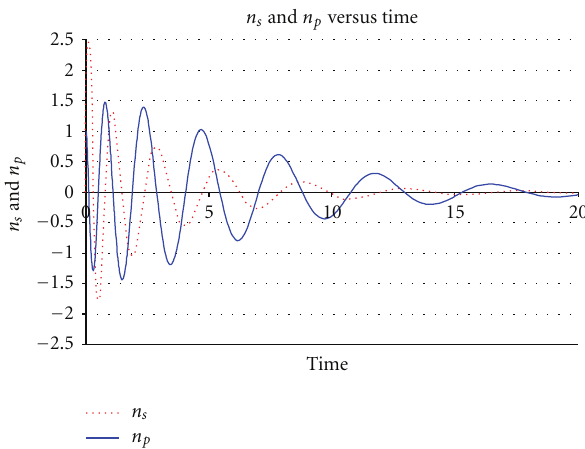
Figure 3: Shown are solutions to the di ff erential equation (3.2.7- 8). These solutions illustrate that as the amplitude decreases the period grows longer. This amplitude-time behavior for the solar cycle was noticed by Waldmeier [16, 17]. Our equations and the field mapping model display similar